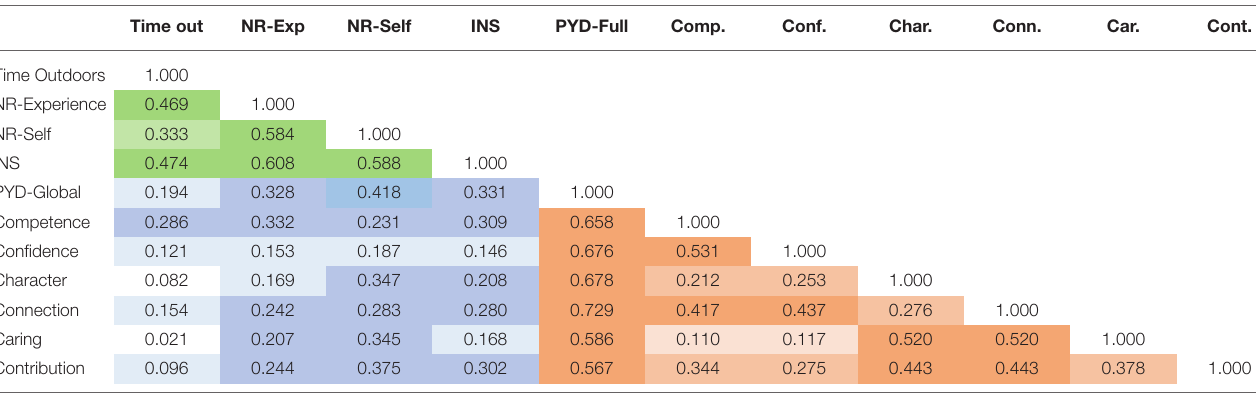
All shaded cells are statistically significant at α = 0.05. Darker shades represent stronger associations. Correlations among nature variables depicted in green. Correlations among PYD variables are depicted in orange. Correlation between nature and PYD variables are depicted in blue. NR-Exp, Nature Relatedness-experience Scale ( Nisbet et al., 2009). NR-Self, Nature Relatedness-self Scale (Nisbet et al., 2009). INS, Inclusion of Nature in Self scale (Schultz, 2001).